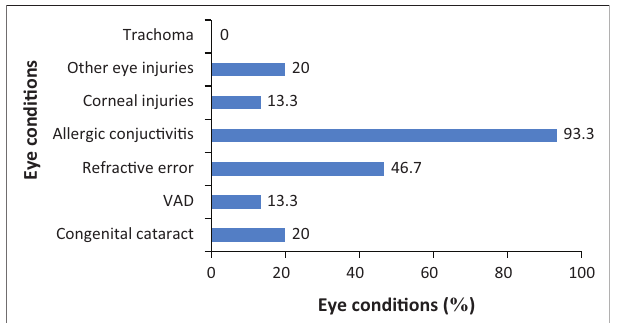
FIGURE 3: Eye health practitioners who reported conditions that children presented with at the eye